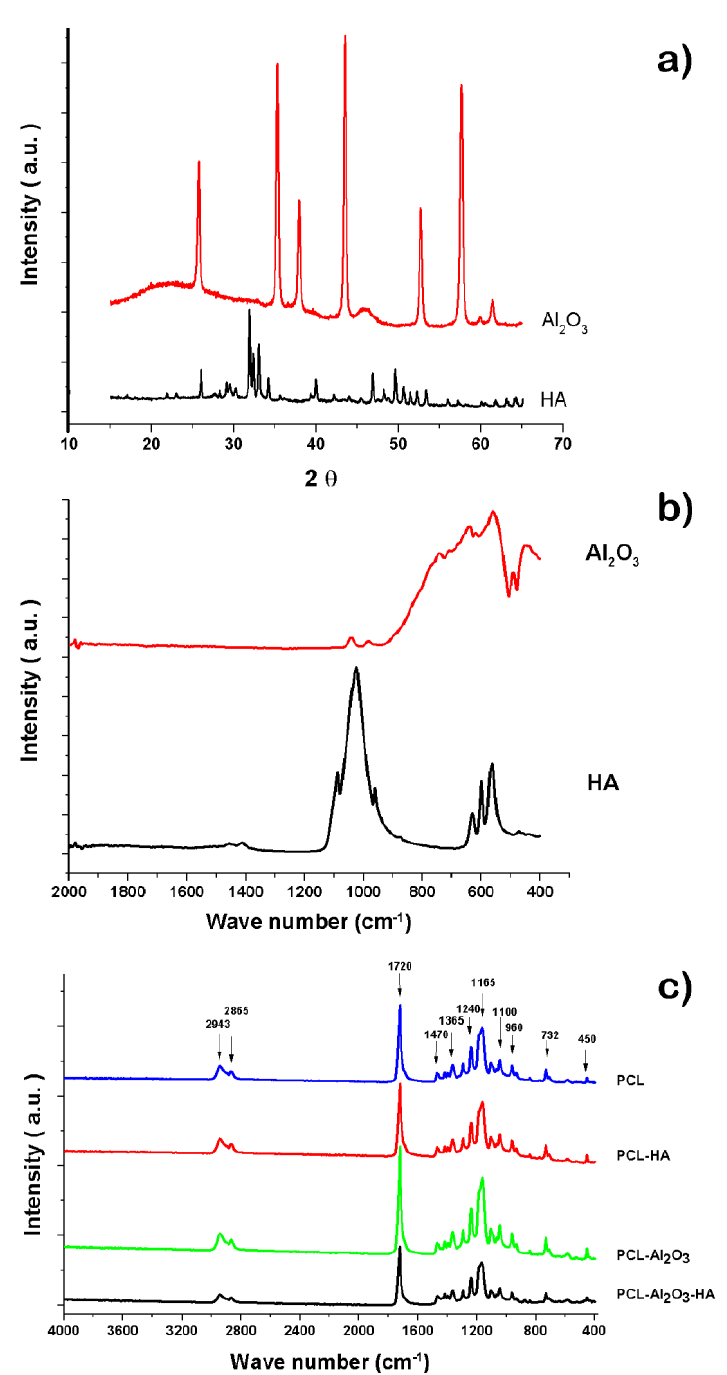
Figure 4. ( a , b ) Infrared spectrum obtained from the nanopowders of hydroxyapatite and α -Al 2 O 3 ; ( c ) infrared spectrum obtained from the different nanofibers PCL, PCL-HA, PCL- α -Al 2 O 3 , and PCL-HA- α -Al 2 O 3 .